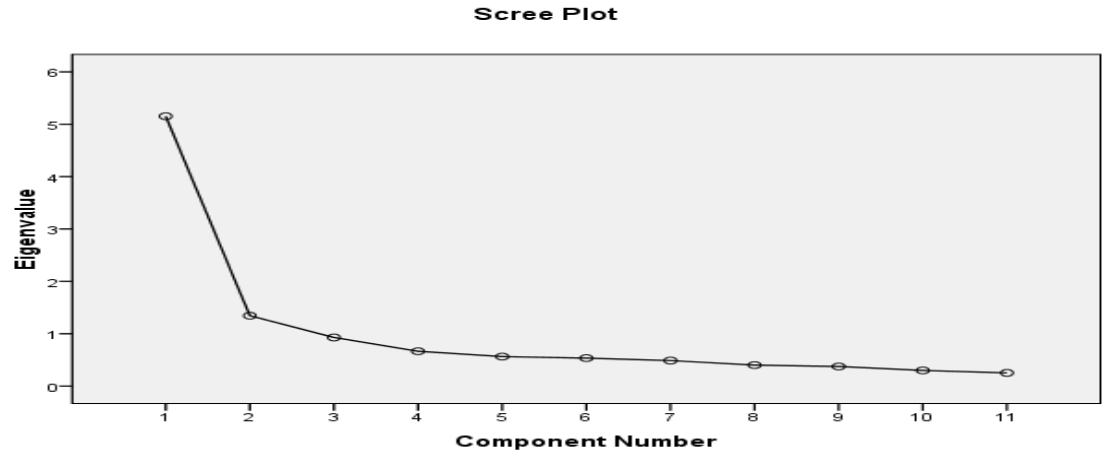
Fig. 3: Scree Plot for Environmental Worry Index (EWI) Table 2: Results of Inter-corelation analysis among study scales